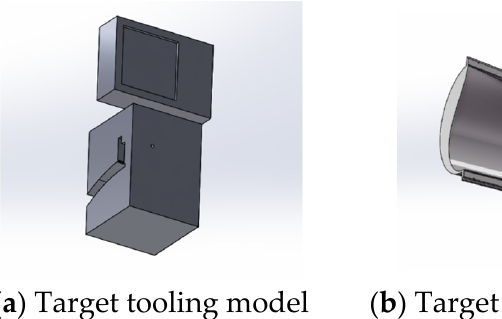
( b ) Average error of optimized target points projection for spatial coordinates Figure 7. Comparison of the average error of target points for the two optimization strategies. It can be seen that the error of the projected plane coordinates of the target point has less influence on the pose calculation compared to the spatial coordinates, and the two optimization methods are run several times without considering the time cost to obtain individuals with errors of 0.0037 mm and 1.3765 × 10 − 5 mm, respectively. Therefore, it can be seen that the main source of the pose calculation error is the offset of the spatial position of the target point generated by the deformation of the projected object itself. 4.2. Indoor 3D Printing Model Projection Experiment Firstly, the camera and the scanning galvanometer are calibrated using a randomly positioned target, as shown in Figure 8, and the transformation from the camera to the scanning galvanometer is given by the camera coordinate system { } c , the scanner coor- Machines 2023 , 11 , x FOR PEER REVIEW